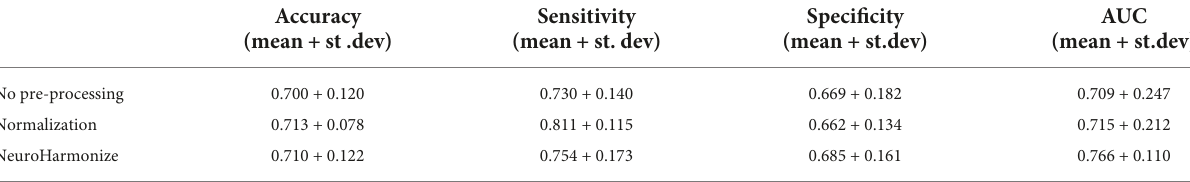
TABLE 3 Performances of PD classification model from different pre-processed radiomics